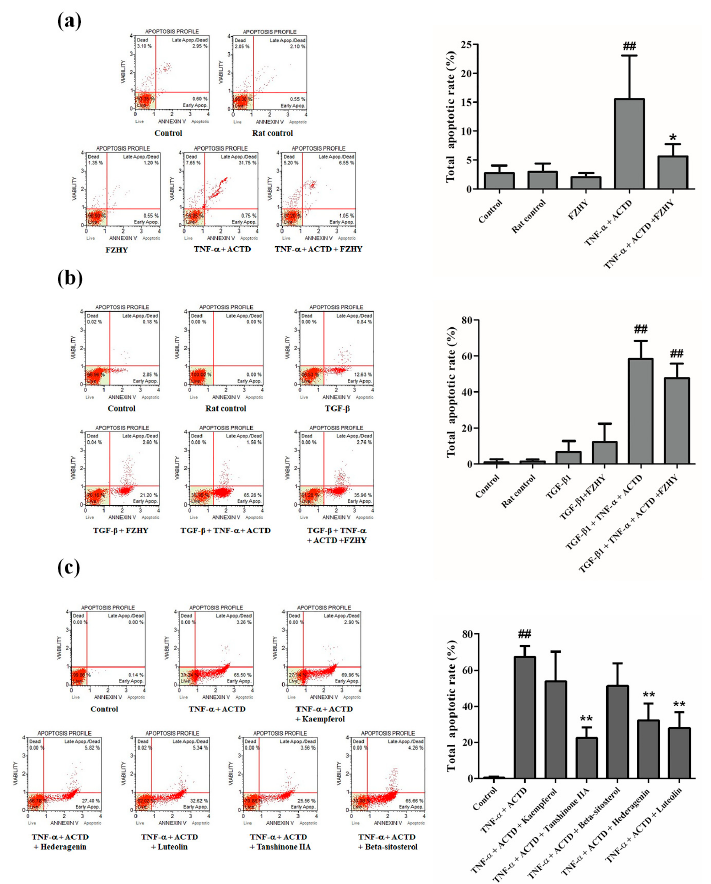
Figure 4. Apoptosis assay. ( a ) Effects of FZHY-medicated serum on L02 cells apoptosis. ( b ) Effects of FZHY-medicated serum on Lx2 cells apoptosis. ( c ) Effects of kaempferol, hederagenin, luteolin, tanshinone IIA and beta-sitosterol on L02 cells apoptosis. FZHY, FZHY formula. ## p < 0.01, compared with the control group. * p < 0.05, ** p < 0.01, compared with the TNF- α + ACTD group. Repeated 4